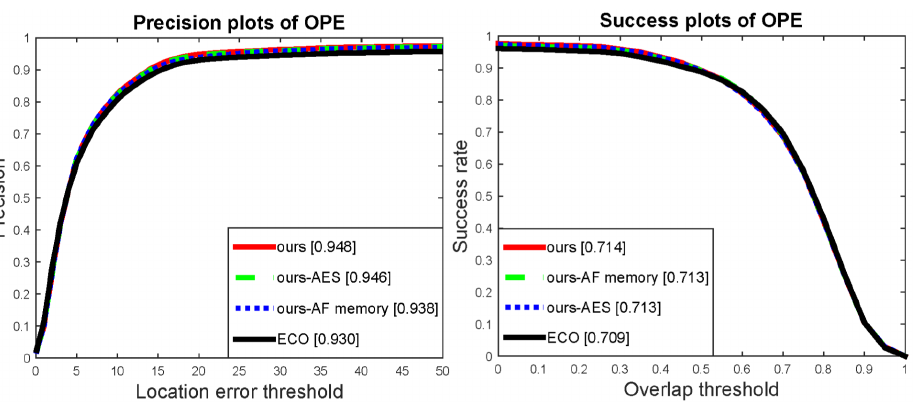
Figure 6. Ablative experiments on the OTB-2013 dataset. The area-under-curve (AUC) score of the success plot and the score of the precision plot are represented in the legend, respectively.